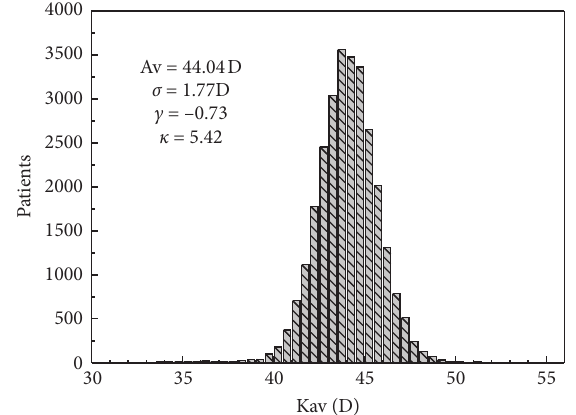
Figure 3: Histogram of the average corneal power with 0.5 D bins. In the inset, the main statigraphs of the distribution are